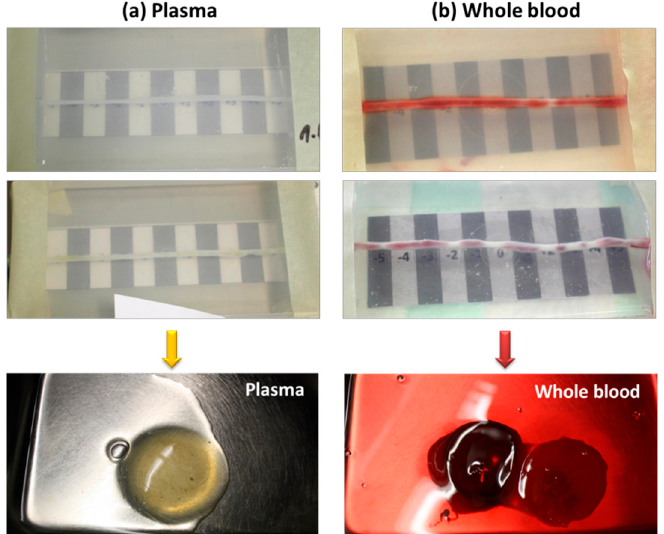
Figure 4. Representative macroscopic images of the artery models after the experiments with ( a ) plasma and ( b ) whole blood. Lower panel shows clots washed out after the